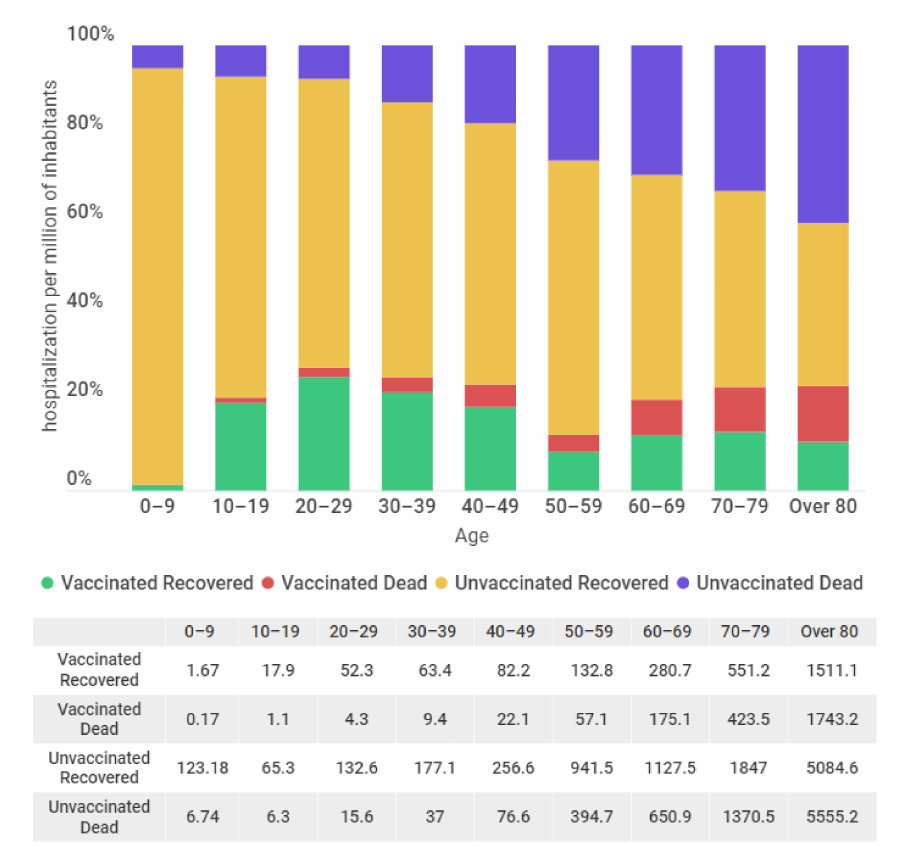
Figure 1. Hospitalizations and in-hospital deaths per million inhabitants between 1 January 2022 and 23 March 2022, according to vaccination status and age group. Unvaccinated included partially vaccinated